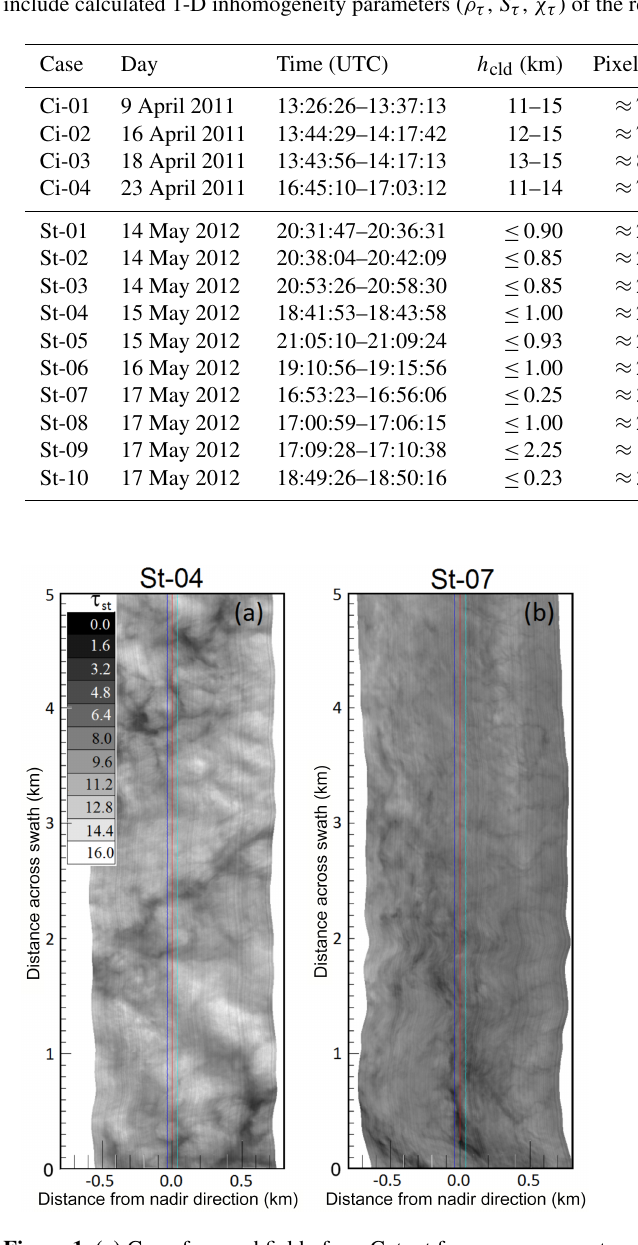
Figure 1. (a) Georeferenced field of τ st . Cutout from measurement case St-04 with 60s measurement duration. The dark blue, red, and light blue lines illustrate the nadir viewing direction in a range of ± 1 ◦ . (b) Same as panel (a) for case